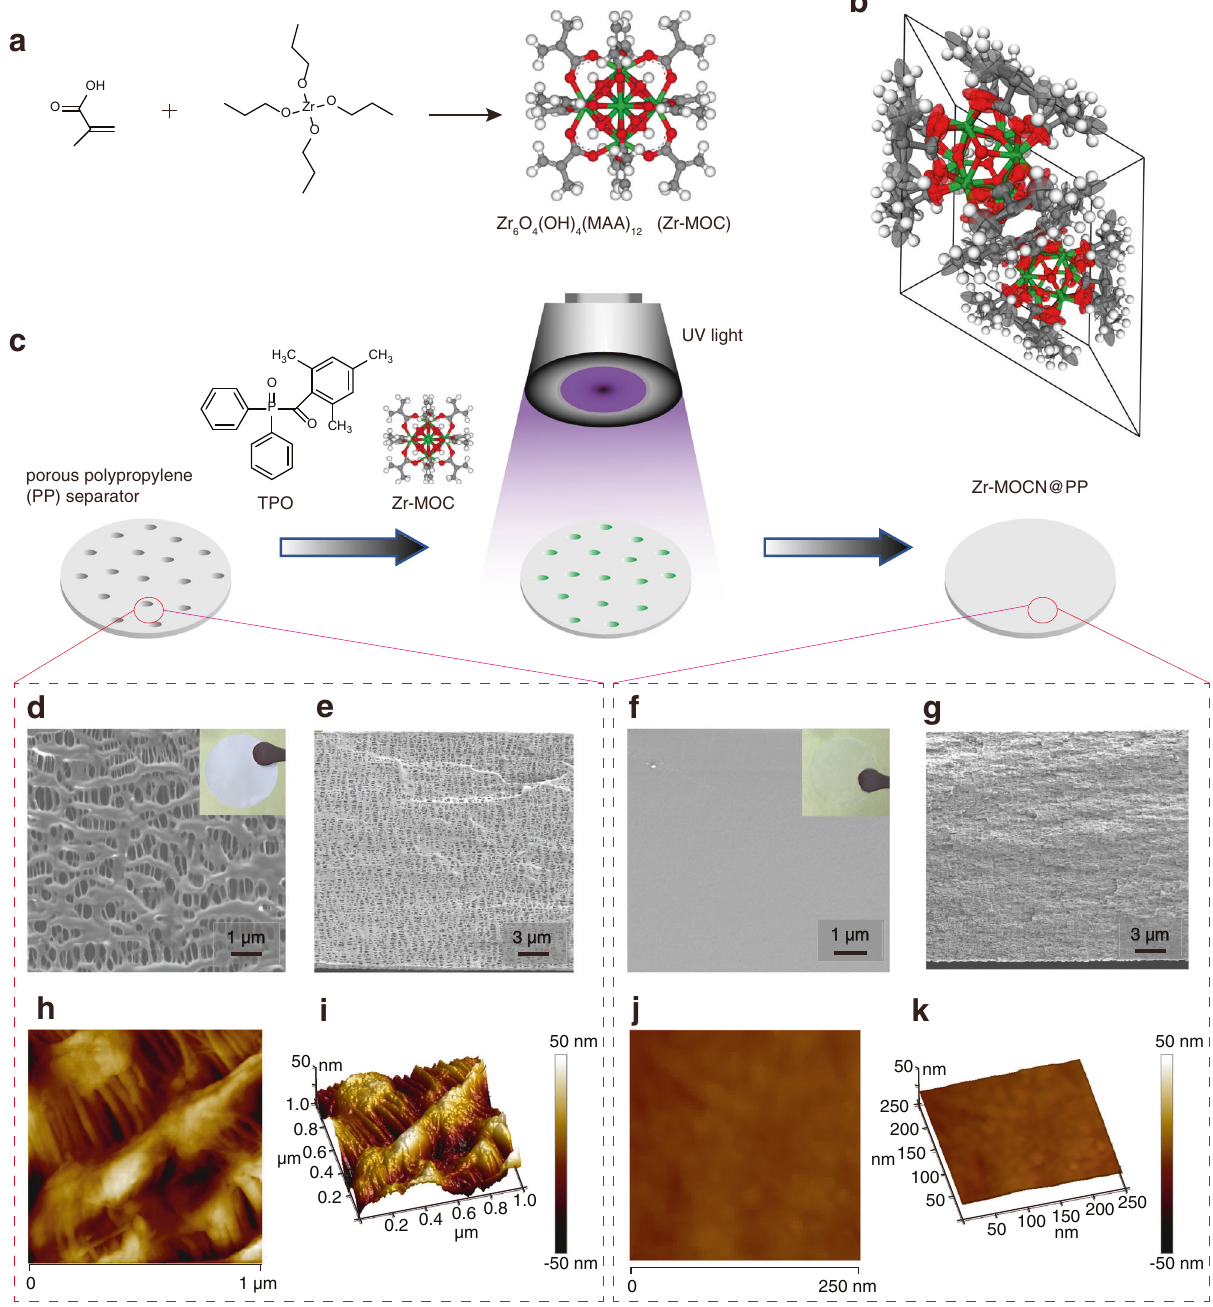
Fig. 1 Photopolymerization of the photoresist separator and its microscopic characterization. a , b Synthesis and crystalline structure of Zr-MOC. (Color code: gray ball, C; red ball, O; white ball, H; green ball, Zr). c Fabrication of the Zr-MOCN@PP membrane via photopolymerization. SEM images of the top and cross-section view of: d , e The PP separator; f , g Zr-MOCN@PP. Insets are photos of the membrane. AFM images of: h , i The PP separator; j , k Zr-